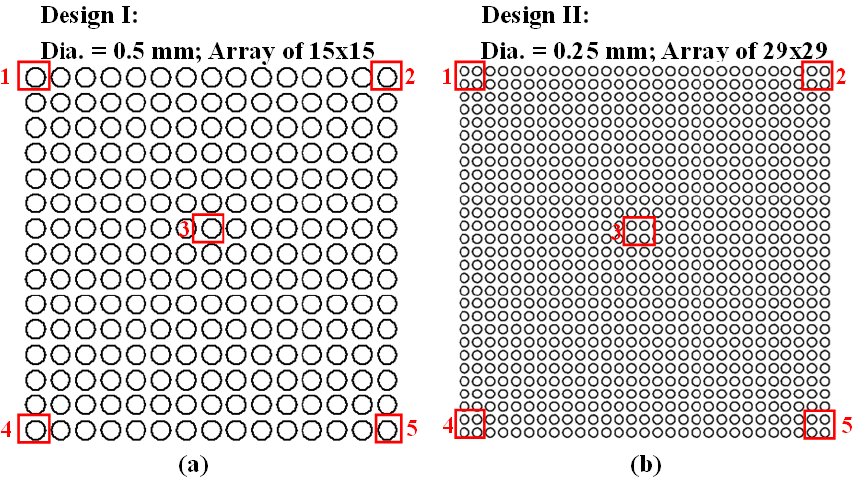
Figure 2. Proposed MLA designs: ( a ) Design I: 15 × 15 array comprising microlenses with 0.5 mm diameter and 0.15 mm spacing; and, ( b ) Design II: 29 × 29 array comprising microlenses with 0.25 mm diameter and 0.1 mm spacing. Red squares indicate the five locations from which measurements were obtained to determine membrane thickness uniformity and lens height uniformity of samples.